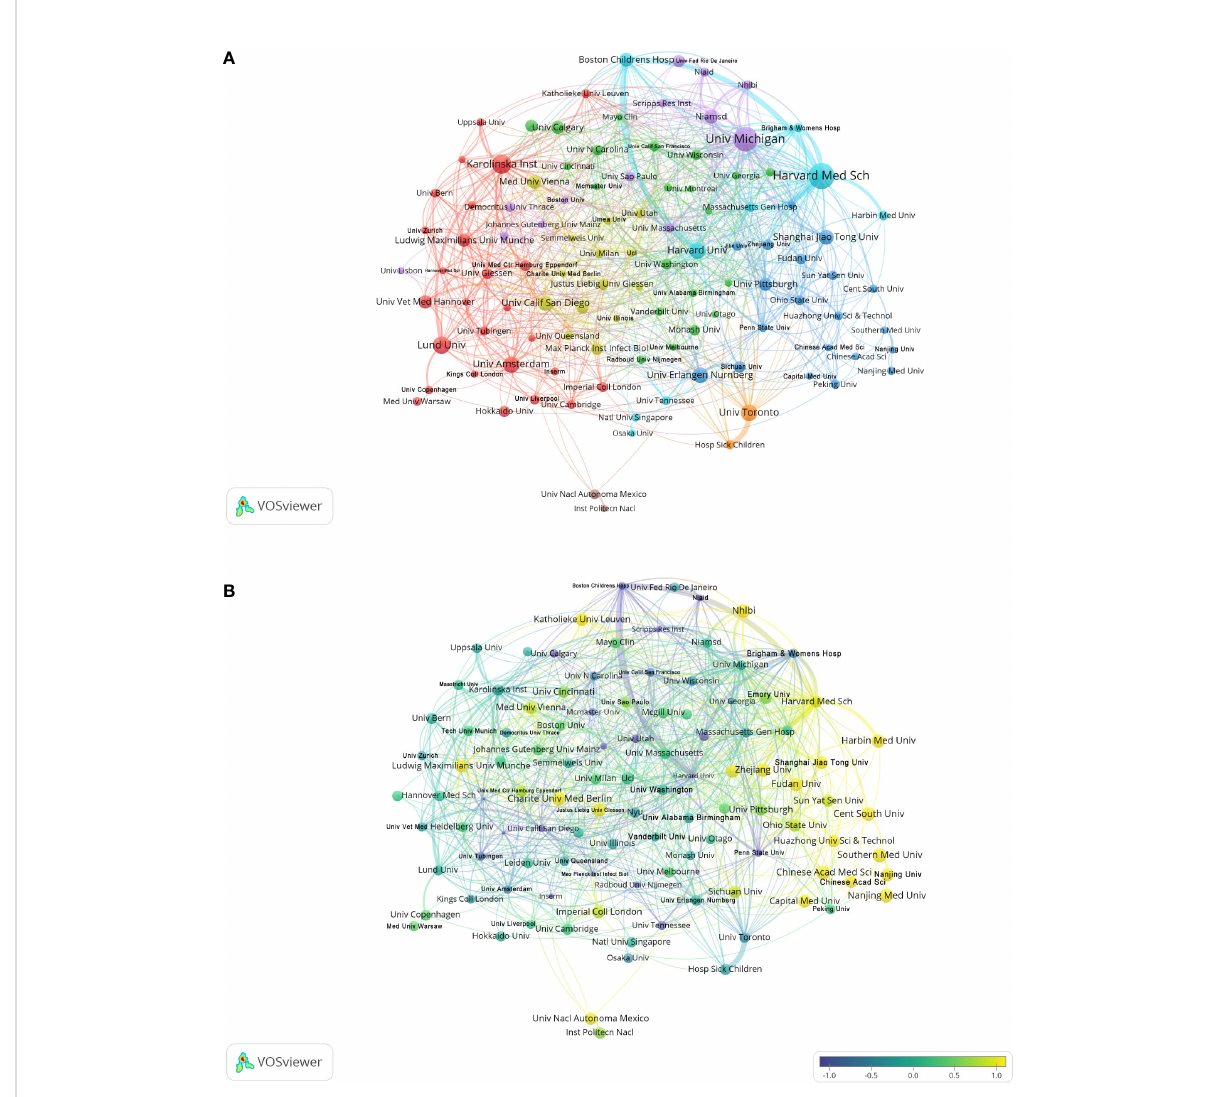
FIGURE 3 Analysis of NETs-related institution. (A) Analysis of collaborative network visualization of institutions in VOSviewer. The fi gure shows the institutions with more than 5 documents. The nodes of different colors represent the institutions of different clusters, and the size of the nodes indicates the frequency of their occurrence. (B) Analysis of the number of articles published by institutions in recent years. The recent 5 years heat value of each institution is obtained by dividing the number of publications in recent 5 year by the total number of publications.